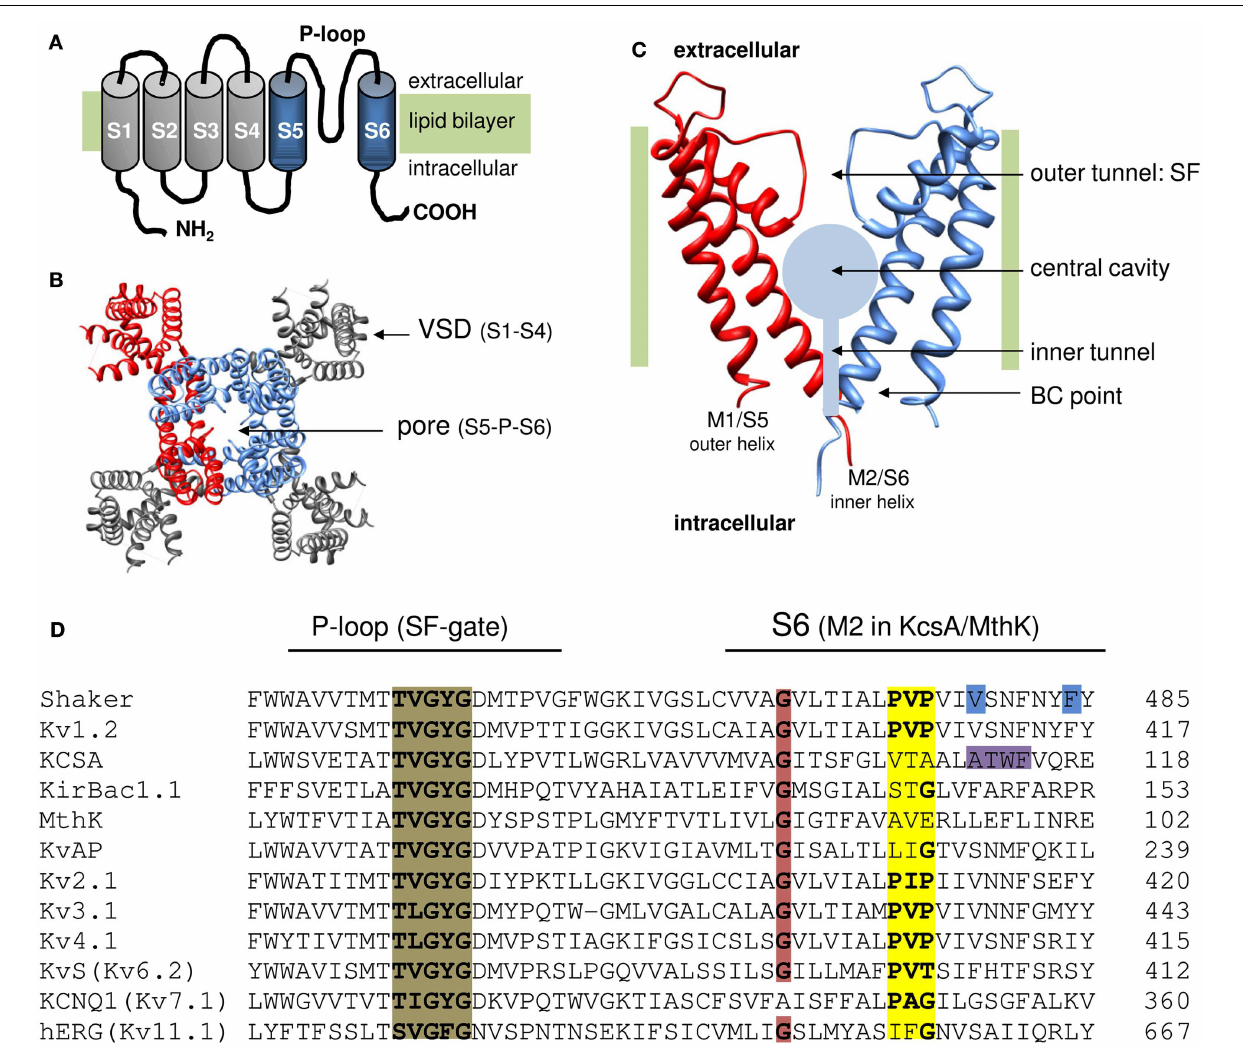
FIGURE 1 |Topology of K channels. (A) Cartoon of the six transmembrane segment (S1–S6) one P-loop (6Tm-1P) topology of a Kv channel α -subunit with both amino (NH 2 ) and carboxyl (COOH) terminus located intracellular.The S1–S4 segments form theVSD (represented in gray) and the S5-P-loop-S6 region assembles with three other pore domains into the K + permeation pathway. (B) Top view (from the extracellular side) of the 3D structure of the Kv1.2 channel (protein data bank accession code 2A79; Long et al., 2005).To illustrate the fourfold symmetrical assembly of the α -subunits into a functional channel, one α -subunit is represented in red. In the other subunits the pore region (S5-P-loop-S6) is colored blue and theVSD (S1–S4) is represented in gray. Note that the pore regions form a centrally located K + pore that is surrounded by four independentVSDs. (C) Side view of the pore module of the 2Tm-1P K channel KcsA that was crystallized in the closed state (protein data bank accession code 1BL8; Doyle et al., 1998).The first transmembrane segment M1 (which resembles S5 in Kv channels) locates at the periphery and faces the lipid bilayer whereas the second transmembrane segment M2 (corresponding to S6) forms the inner pore helix.The front and back α -subunit are omitted to illustrate the layout of the K + permeation pathway that – from the intracellular to the extracellular